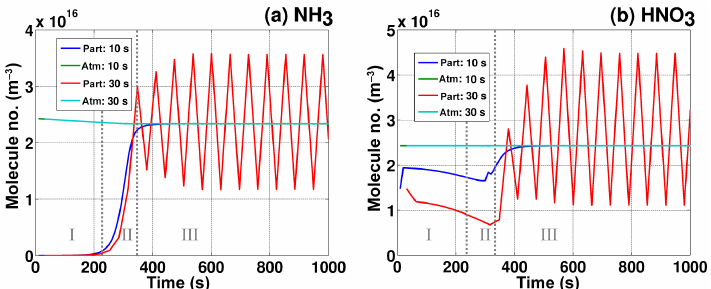
Figure 1. Ambient (atm) and particle surface (part) partial pressures given as molecular number concentration equivalents of (a) NH 3 and (b) HNO 3 as a function of time, in a typical example of how chemical interaction may lead to oscillations and thus limit the numerical integration time step. For both species, initial ambient concentrations are equivalent to 1ppb. Species are dissolving into a monodisperse aerosol at standard temperature and pressure conditions, relative humidity is 80%, dry particle size is r = 50nm, their concentration is 100cm − 3 . Initially, the aerosol aqueous phase consists exclusively of a binary H 2 SO 4 / H 2 O liquid. The temporal evolution of the partial pressures is simulated with the Jacobson (1997) scheme, integrated at fixed time steps of 10 and 30s, respectively. The three characteristic stages of the equilibration of the particle aqueous phase with the gas phase are indicated (I–III, see text). Phase 1 is equivalent to the initial 200s of fast dissolution of NH 3 at almost constant surface pressure. Phase 2 corresponds to the next 200s during which surface pressure of NH 3 increases along with pH, thus leading to the dissolution of HNO 3 . Phase 3 corresponds to the oscillating period during which the system is close to equilibrium as chemical interaction has become ineffective. Note that for both NH 3 and HNO 3 the atmospheric concentrations are sensibly equal at both time steps. For the gas phase, the data obtained at a time step of 10s (green) may thus not be distinguished from the one obtained at the larger time step